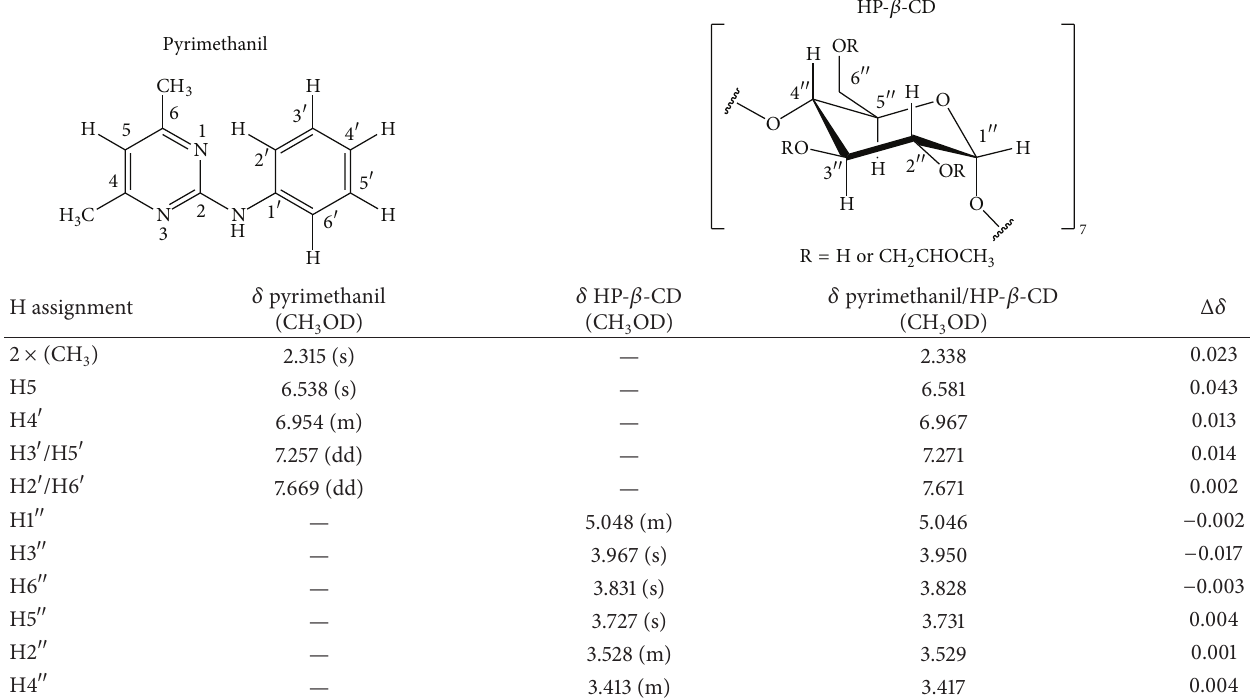
Table 1: 1 H NMR chemical shift ( 𝛿 ) data of pyrimethanil, HP- 𝛽 -CD, and pyrimethanil/HP- 𝛽 -CD inclusion